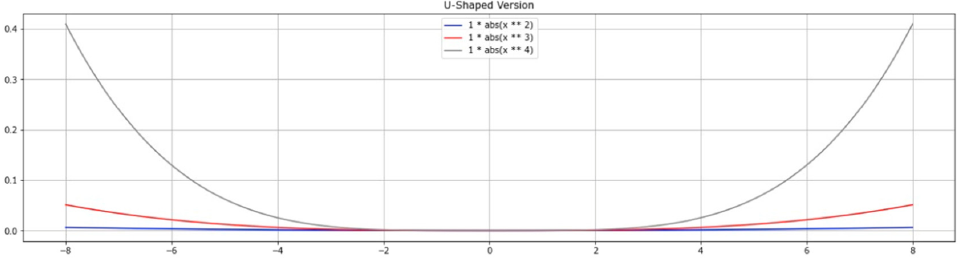
Figure 7. U-shaped transfer function ( U 1– U 3).